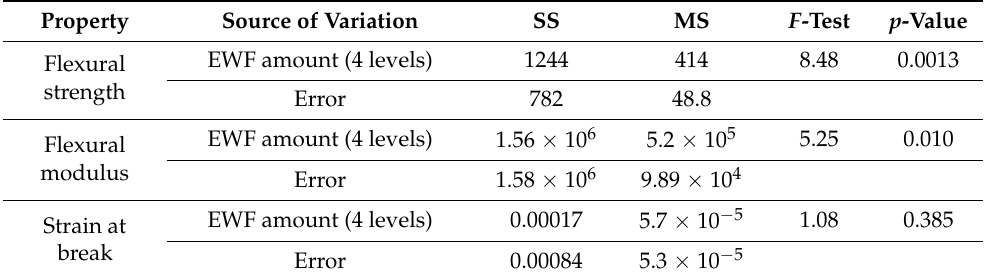
Table 5. ANOVA parameters—amount of EWF as the source of variation.